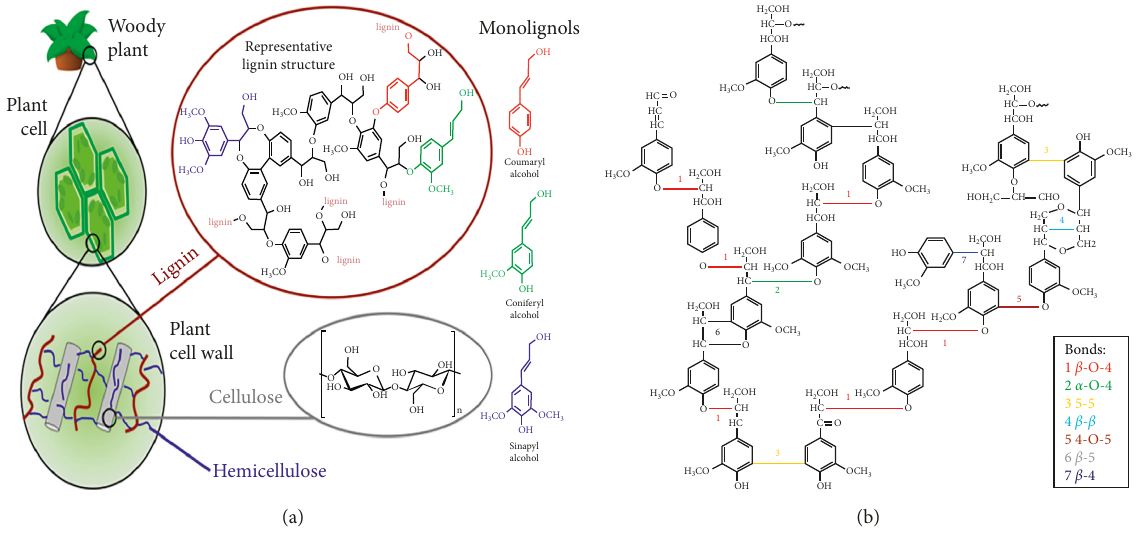
Figure 1: (a) The lignin structure and three main lignin precursors [20] (Copyright @ 2017 Science and Education Publishing CC under 4.0) and (b) typical interunit linkages present in softwood lignin [6] (Copyright @ 2018 Springer CC under 4.0). Table 1: Different characteristics of lignins and the appropriate utilization. Lignin Some key lignin